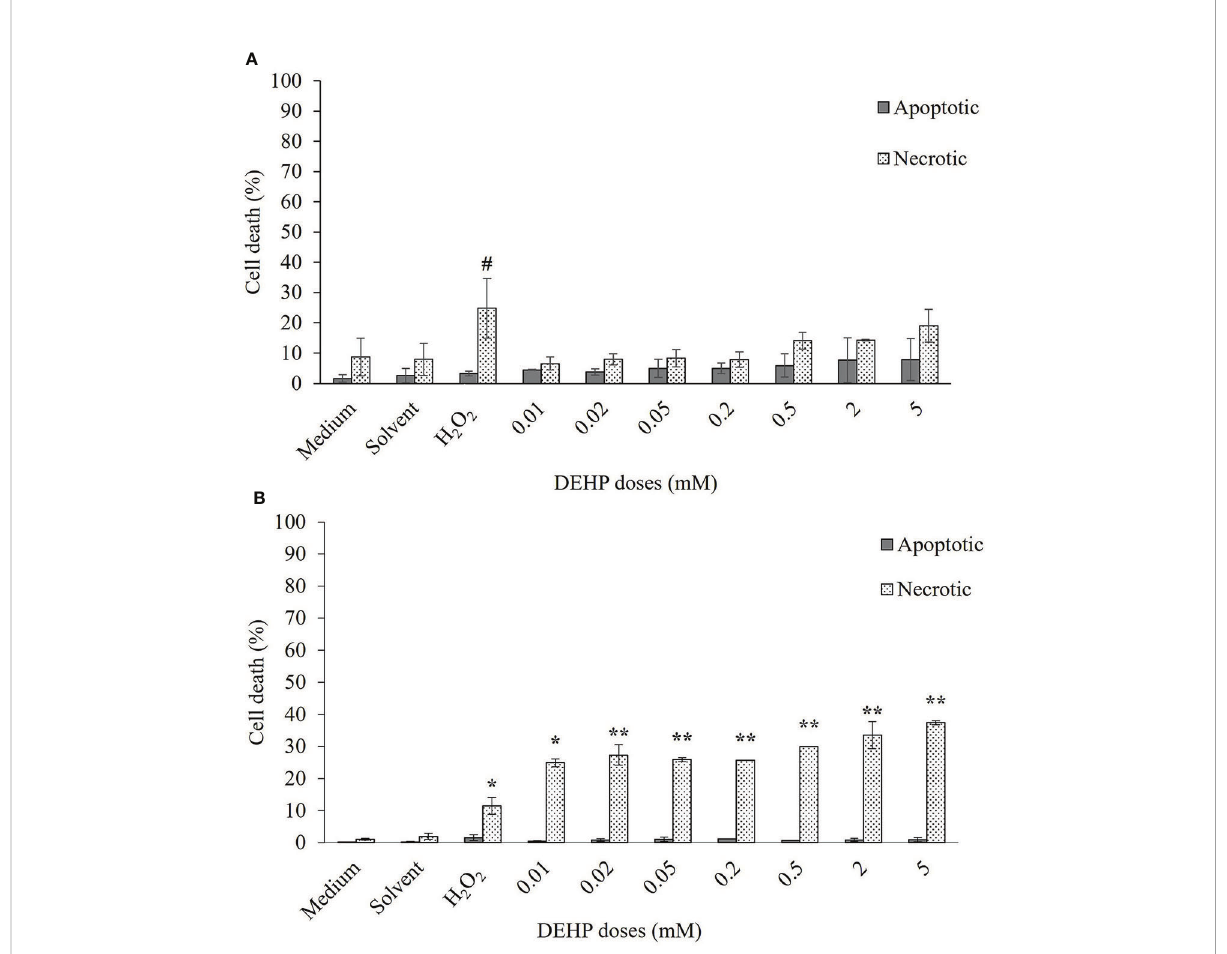
FIGURE 2 Induction of apoptosis and necrosis in TT (A) and CHO (B) cell lines after 24 h of exposure at increasing doses of DEHP. Data are expressed as means ± SD of two independent experiments. One-way ANOVA signi fi cance: # p ≤ 0.05 H 2 O 2 vs medium in TT cell line; * p ≤ 0.05 H 2 O 2 vs medium and treated vs solvent in CHO cell line; ** p ≤ 0.01 treated vs solvent in CHO cell line. TT, Tursiops truncatus ; CHO, Chinese hamster ovary; DEHP,